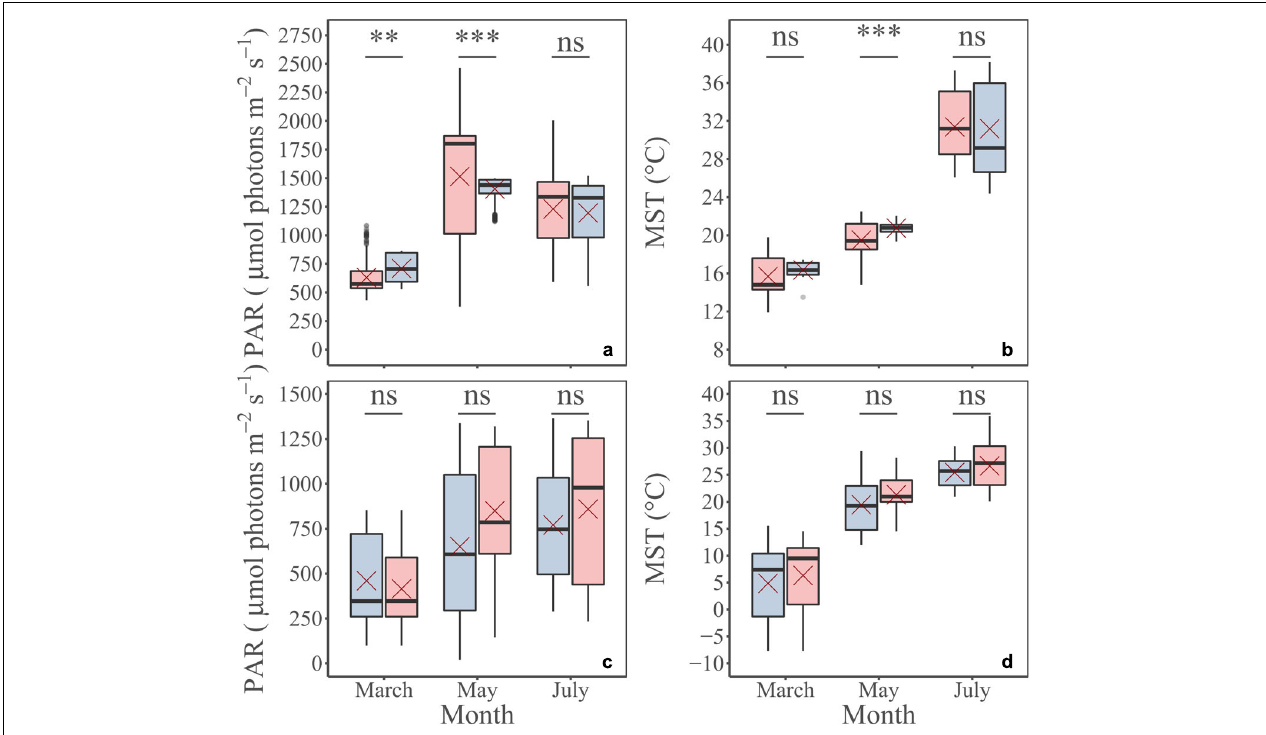
FIGURE 8 | A priori physical environment validation. PAR (a) and MST (b) measured in situ (blue) and simulated by MARS-3D (pink) for the same period: March, May, and July; PAR (c) and MST (d) simulated by MARS-3D, averaged during daytime emersion periods 2 weeks before in situ measurements (blue) and satellite scenes acquisitions (pink). Red crosses correspond the mean value of PAR and MST for the corresponding period. Mann Whitney test; p -value: ns, p > 0.01; * p ≤ 0.01; ** p ≤ 0.001; *** p ≤